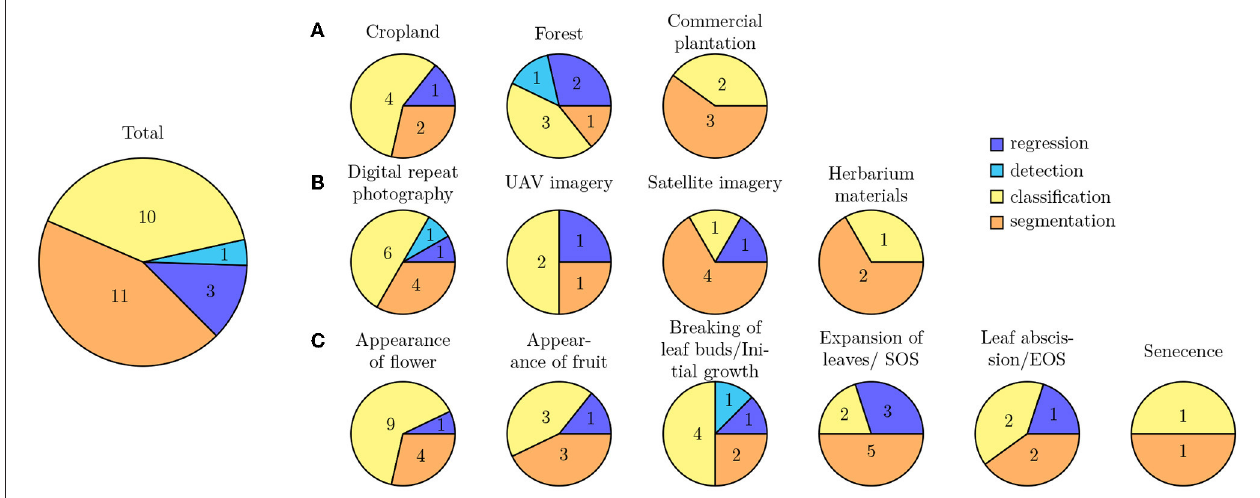
FIGURE 7 | Overview of all DL methods used for different types of (A) landuse, (B) image origin, and (C) type of phenology expression under study.